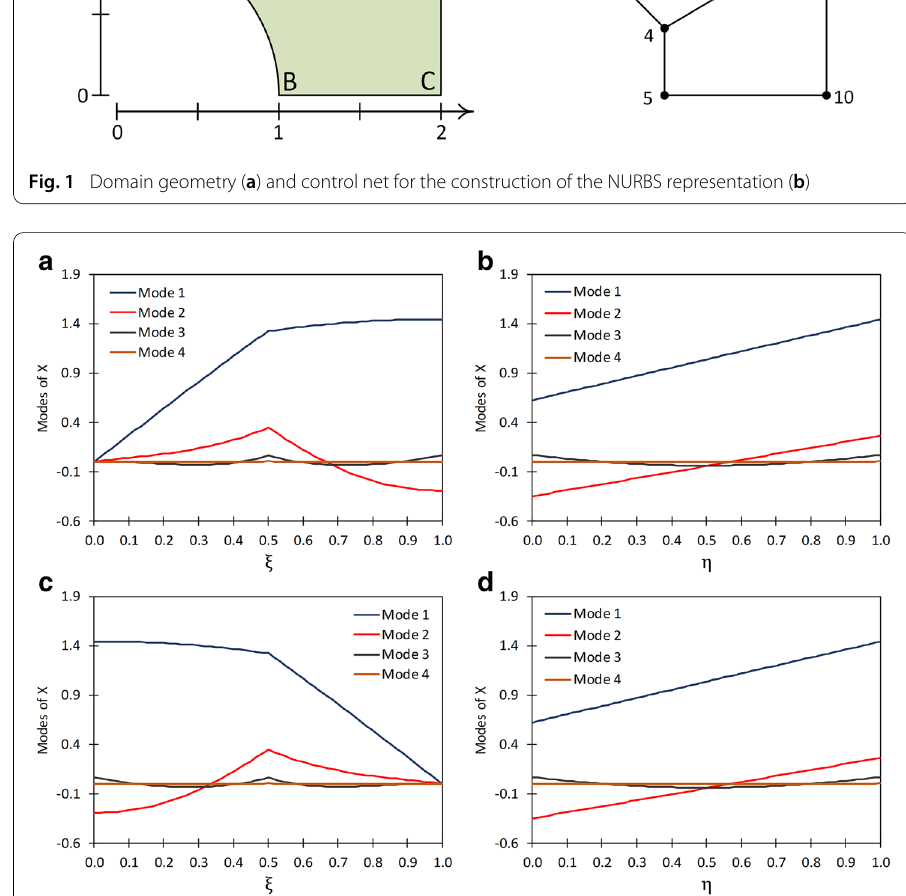
( ξ ) X 1 i ; b M T ( η ) X 2 i ; c M T ( ξ ) Y 1 i ; 1 2 1